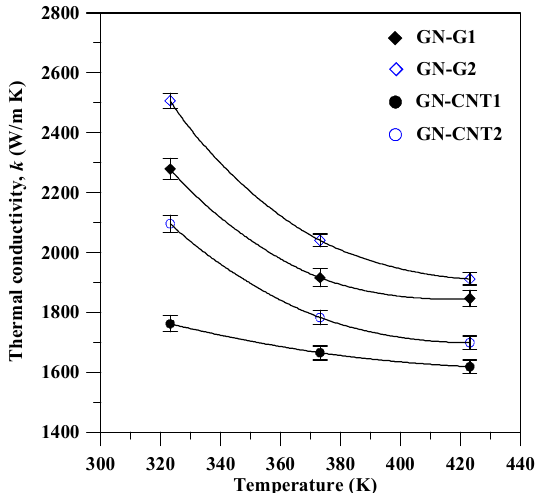
Figure 3. The variation of k values of heat sinks with operating temperature. This figure shows that the k value is a decreasing trend with temperature, revealing that the thermal transport in GN-based heat sink is mainly dominated by phonon-boundary